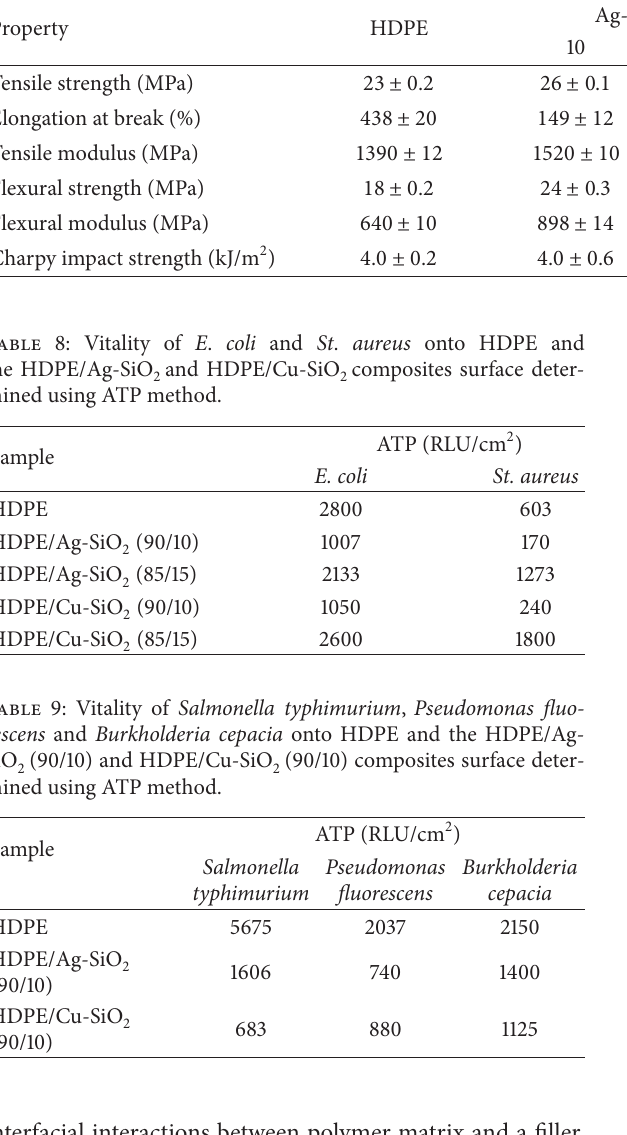
or Cu-SiO ; tensile and flexural 2 2